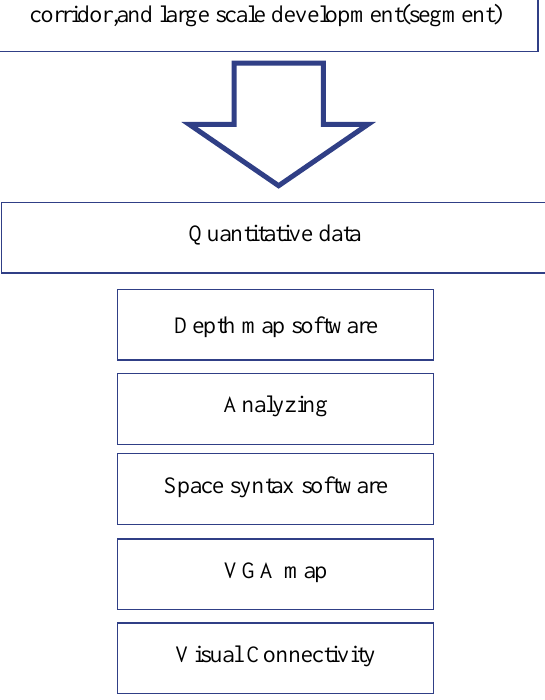
Figure 1. Methodology